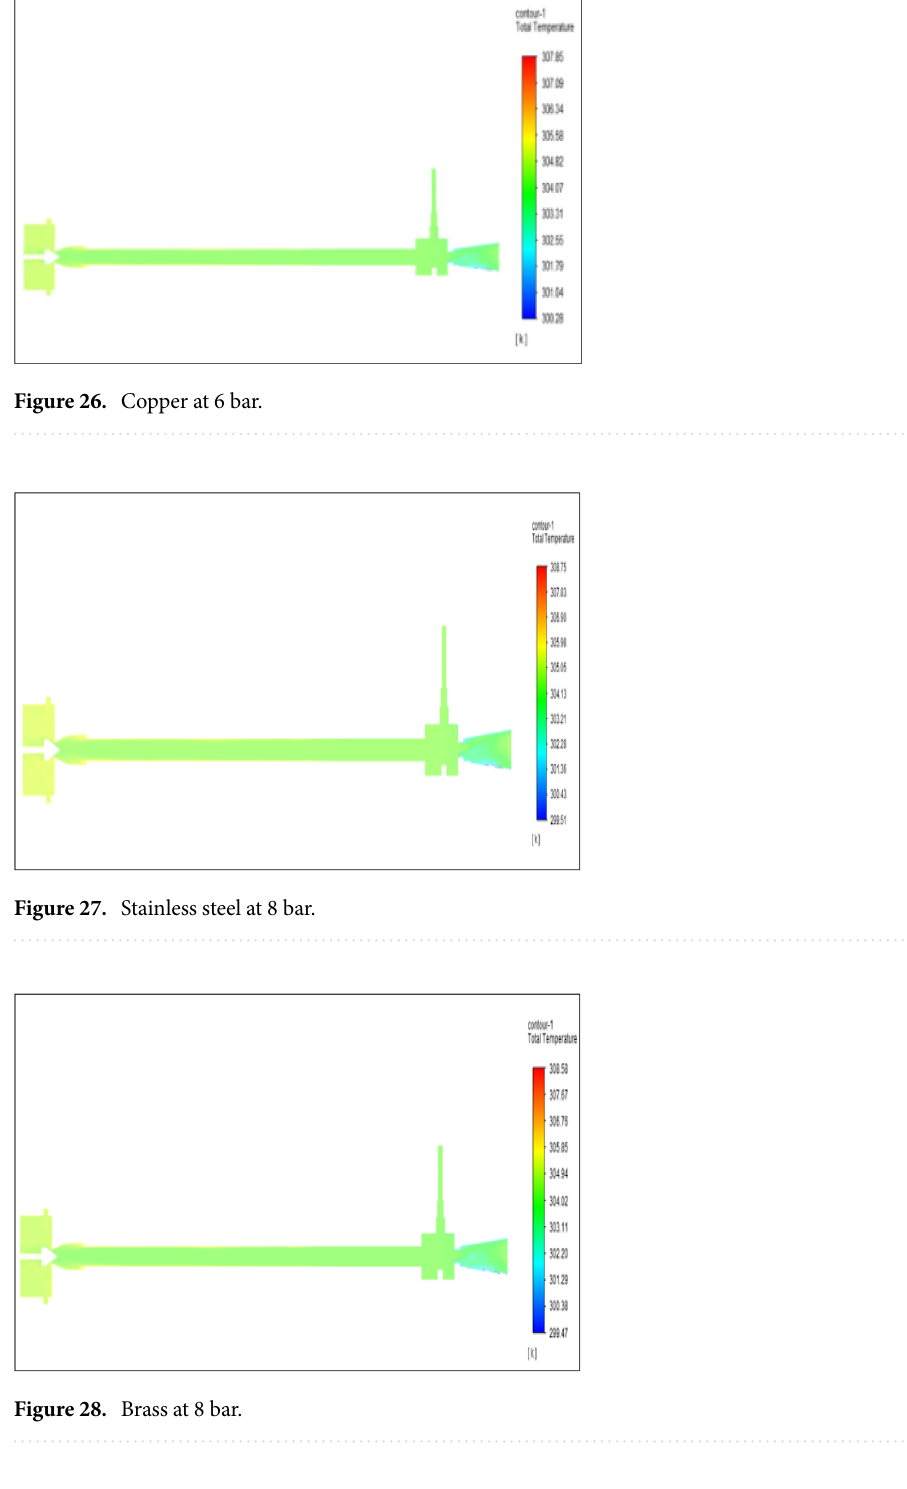
Figure 33 represents to bronze vortex tube with inlet pressure at 8 bars. The inlet temperature of the VT is 303 K. The hot air temperature was obtained at hot end as 308.38 K, at the cold end side obtained a value of 299.49 K. The maximum temperature difference was observed as 8.88 K. Figure 34 represents to copper vortex tube with inlet pressure at 8 bars. The inlet temperature of the VT is 303 K. The hot air temperature was obtained at the hot end as 299.47 K, at the cold end side obtained value of 300.28 K. The maximum temperature difference was observed as 9.38 K.